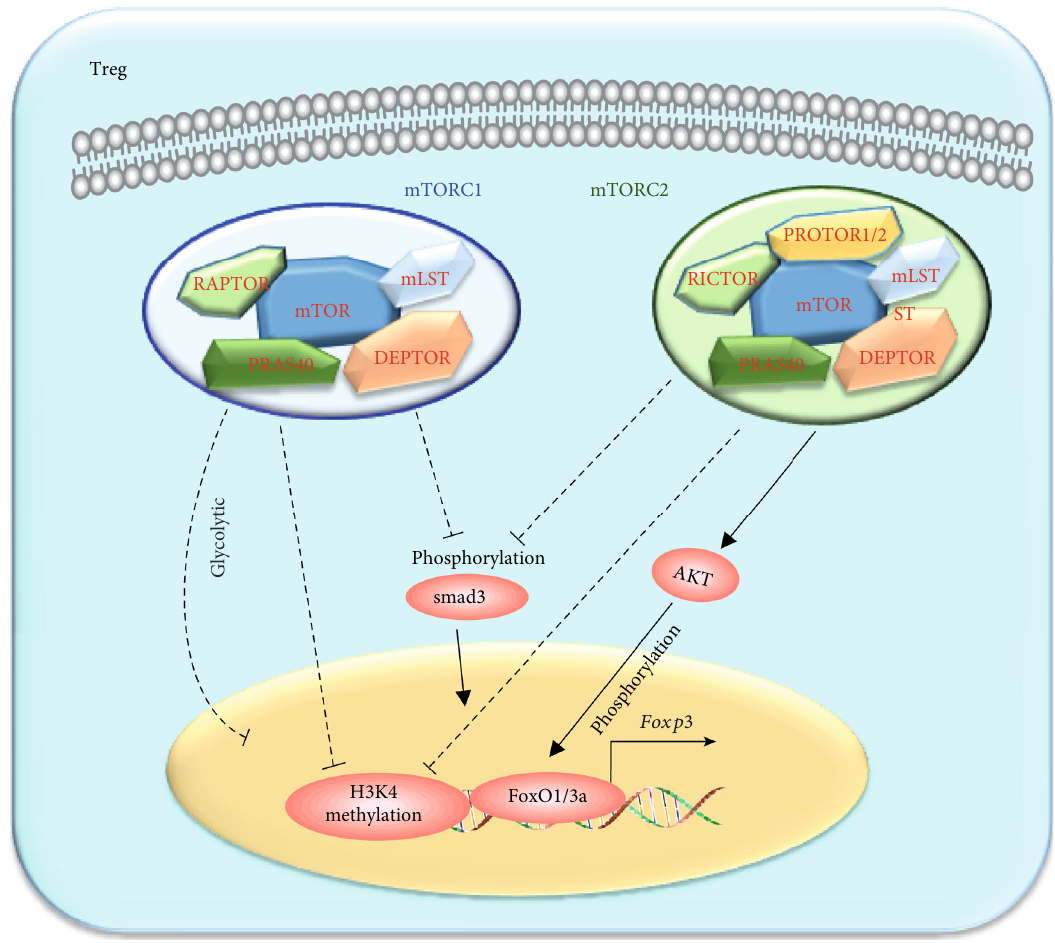
Figure 6: The regulation of mTOR on Treg cell di ff erentiation. Treg cell di ff erentiation is negatively regulated by mTORC1 and mTORC2. mTORC1 and mTORC2 inhibit Treg cell di ff erentiation through inhibiting phosphorylation of smad3 or inhibiting H3K4 methylation near the Foxp3 TSS. Meanwhile, mTORC1 inhibits Treg cell di ff erentiation by increasing glycolytic activity, but mTORC2 inhibits Treg cell di ff erentiation through the ATK-FoxO1/3a